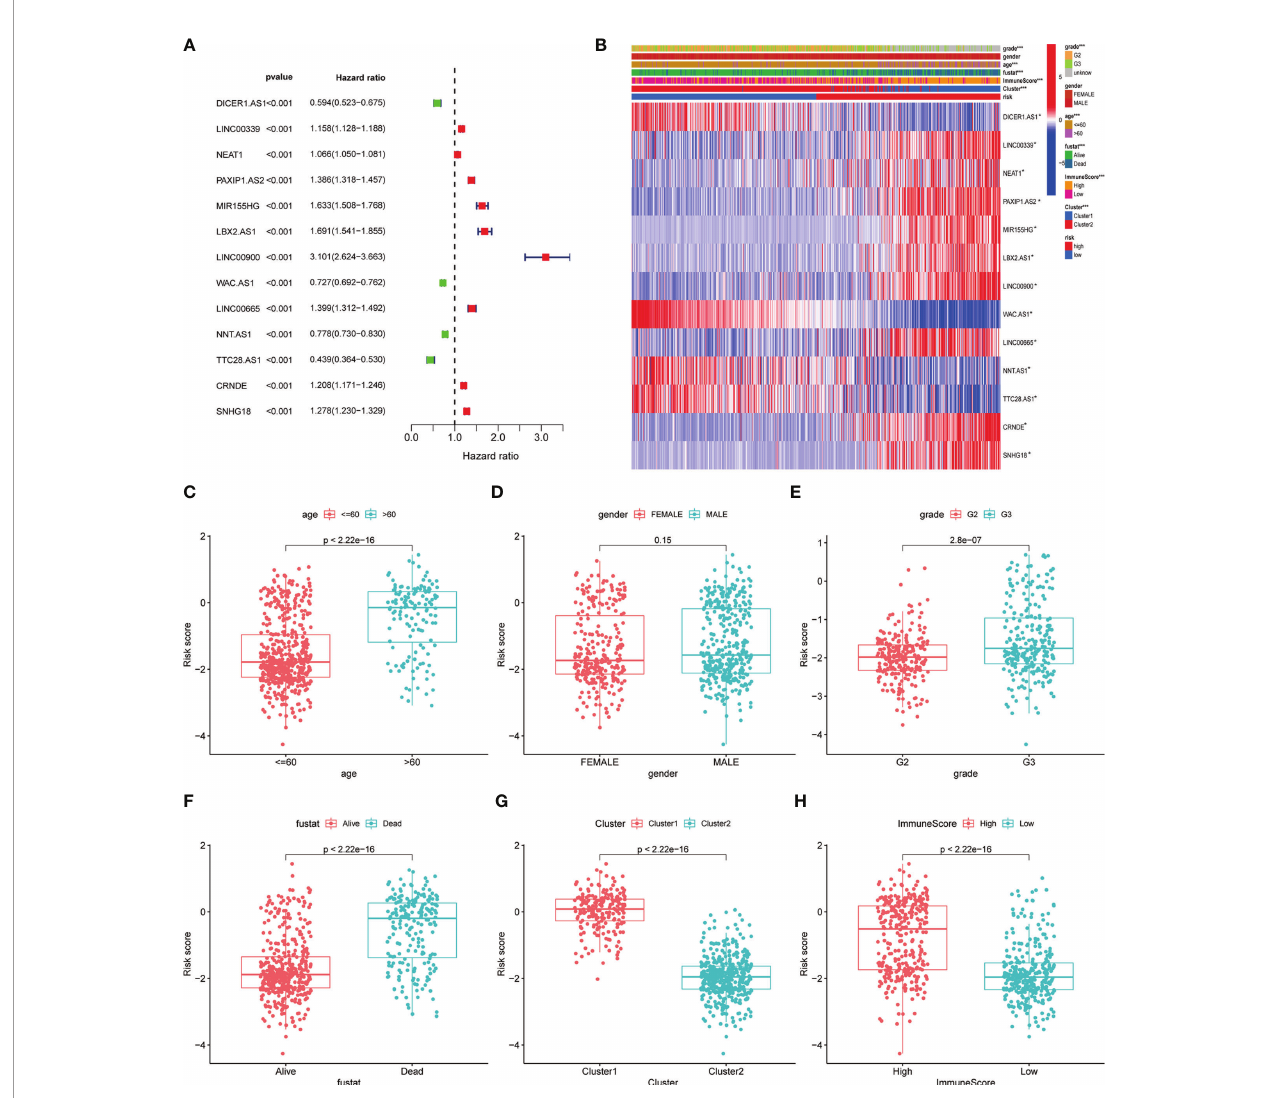
FIGURE 3 | Correlation of clinical characteristic with identi fi ed pyroptosis-related lncRNAs signature. (A) Forest of univariate COX regression for 13 signature lncRNAs. (B) Heatmap showed that correlation of clinical parameters with risk score and expression of 13 lncRNAs in high- and low-risk group. Boxplot showed the comparisons of risk score in different subgroup: (C) age<=60 vs >60, (D) Female vs Male. (E) Grade 2 vs Grade 3. (F) Dead vs Alive, (G) Cluster 1 vs Cluster 2. (H) High immune score vs low immune score. *P < 0.05; **P < 0.001; ***P <